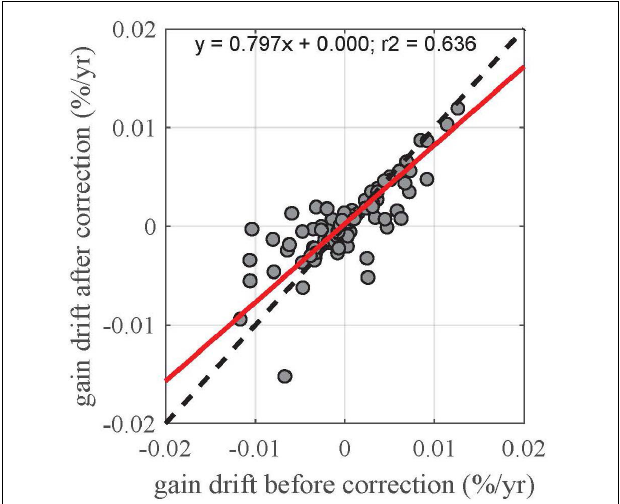
FIGURE 5 | Comparison of post-deployment optode drift before and after application of Bittig et al. (2018a, equation 23). Analysis includes 82 SOCCOM floats. Dashed line depicts the 1:1 relationship; red line is a Model II regression (uncertainty in both X and Y ).